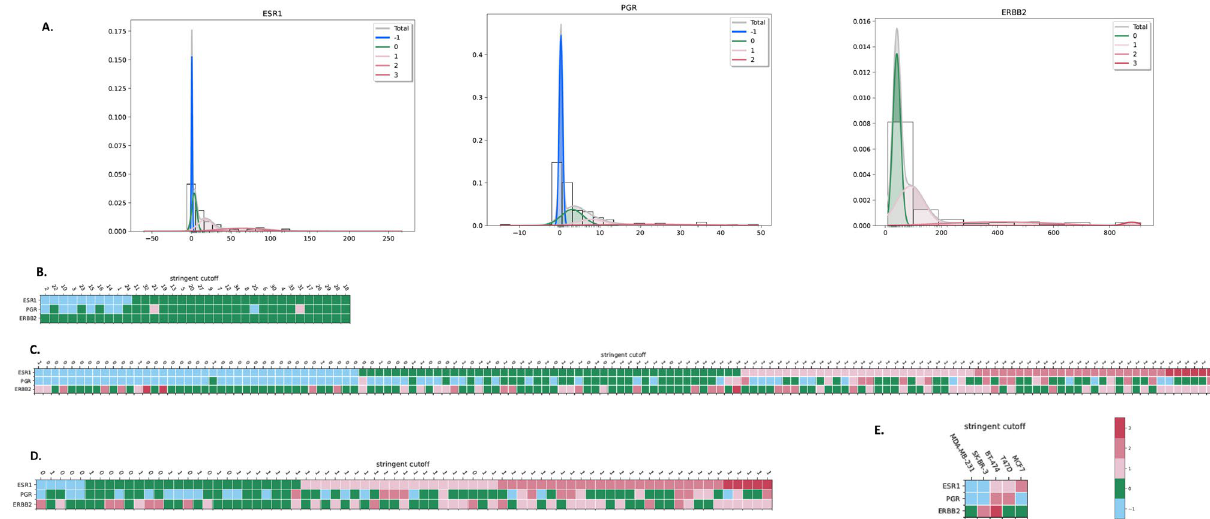
Figure 4. The g3mclass autoclassification on three genes. ( A ) The g3mclass -selected models. The 5-class model parameters for ESR1 mRNA: class − 1 (0.49 ± 0.57; weight 0.25); class 0 (3.34 ± 3.18; weight 0.27), class 1 (17.4 ± 9.22; weight 0.25), class 2 (63.4 ± 29.2; weight 0.19), class 3 (99.5 ± 105; weight 0.05). The 4-class model parameters for PGR mRNA: class − 1 (0.30 ± 0.43; weight 0.48); class 0 (3.09 ± 2.77; weight 0.26), class 1 (7.88 ± 3.49; weight 0.13), class 2 (63.4 ± 29.2; weight 0.12). The 4-class model parameters for ERBB2 mRNA as above in Fig. 2. ( B )–( E ) The g3mclass -created classification heatmaps. The s.cutoff classification heatmaps on ESR1, PGR, and ERBB2 for mammoplasties ( B ), IBC ( C ), DCIS ( D ), and IBC cell lines ( E ). The IHC score for ER-positive (1), and ER-negative (0) cancers are on the top of heatmaps ( C , D ). In E, human breast cancer cell lines: MDA-MB-231 (triple-negative), SK-BR-3 (HER2 overexpressing), BT-474 (luminal B), T47D (luminal A), MCF7 (luminal A). Bar, heatmap’s color scale for